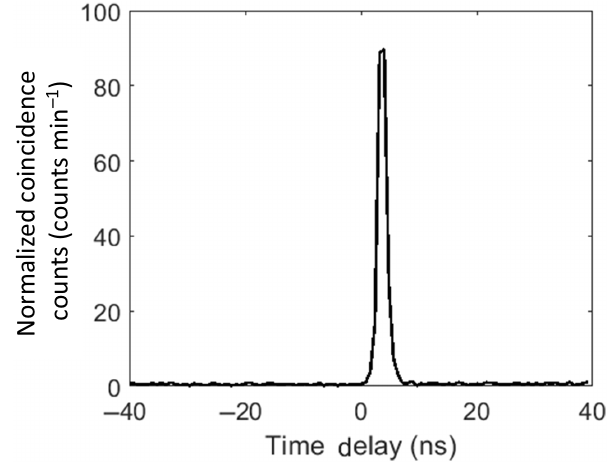
FIG. 8. An example histogram showing the normalized coin- cidence counts (in counts per minute) as a function of the time delay. The slight offset from 0 is due to unequal filter path lengths between the signal and idler